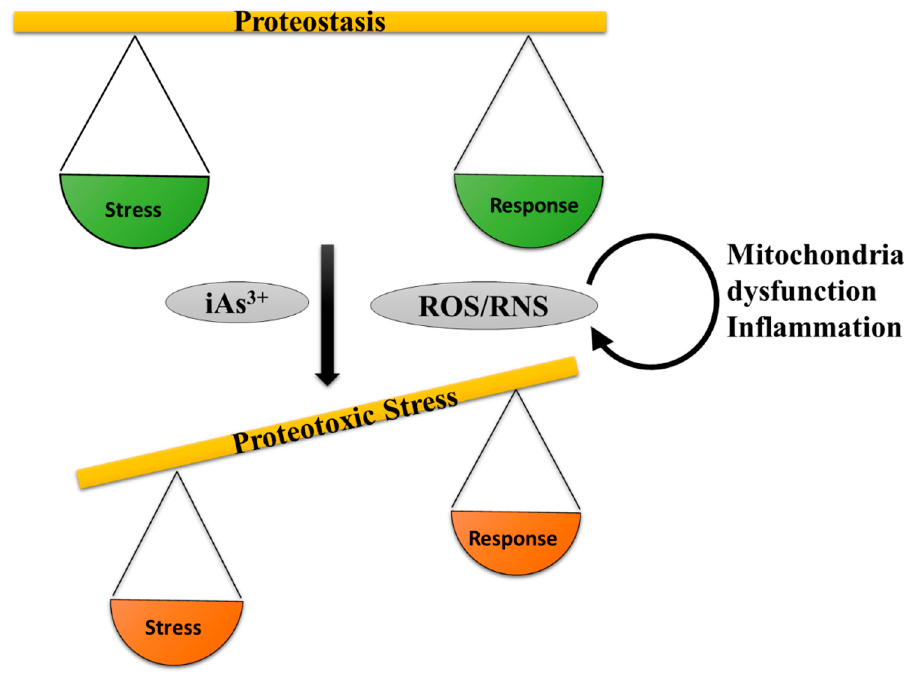
Figure 5. Arsenic-elicited over-production of ROS/RNS alter the equilibrium of